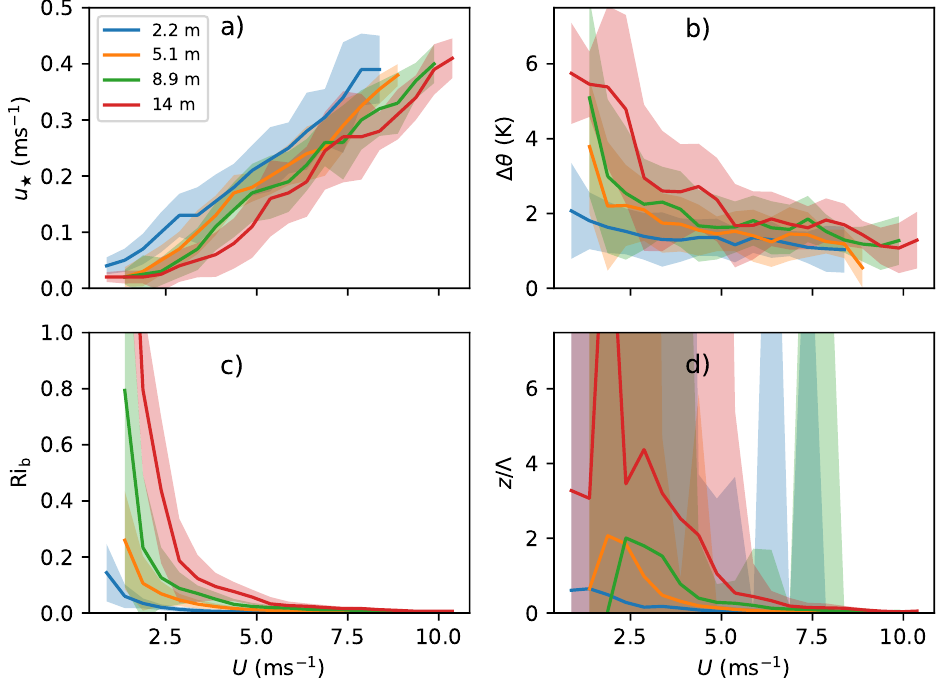
Figure 1. ( a ) u (cid:63) , ( b ) ∆ = θ a − θ s , ( c ) Ri b , and ( d ) z / Λ as functions of mean wind speed U at several heights as observed at the SHEBA station during clear-sky conditions during polar night. The shaded area indicates the ± standard deviation of the corresponding quantity for each